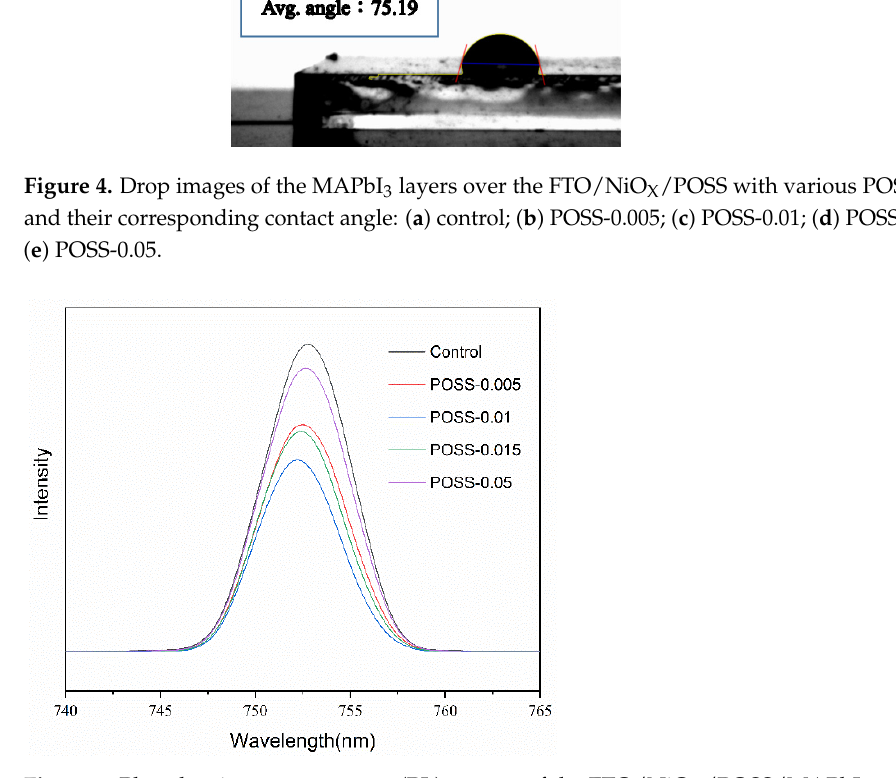
Figure 5. Photoluminescence spectra (PL) spectra of the FTO/NiO X /POSS/MAPbI 3 with various POSS contents.